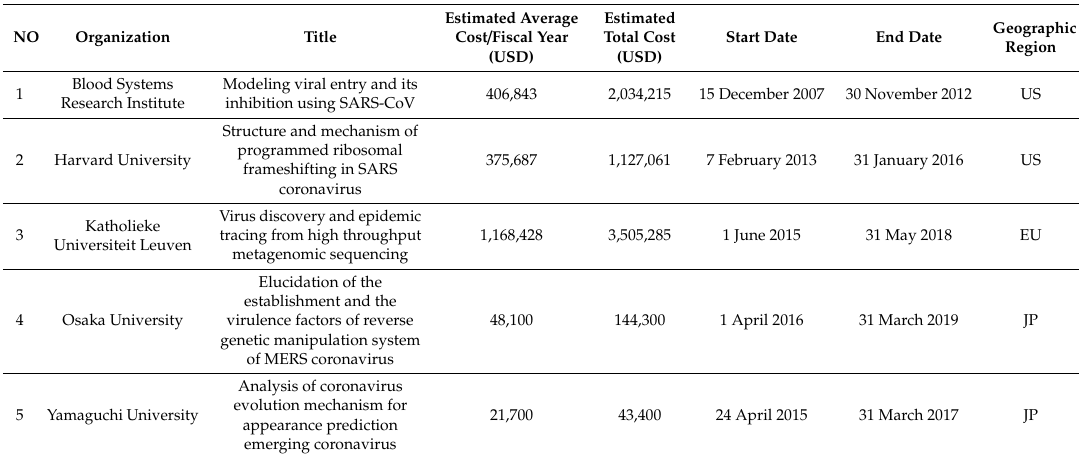
Table 5. Structure–activity relationship modeling-based virus prediction and activity modulation (Sub-Cluster